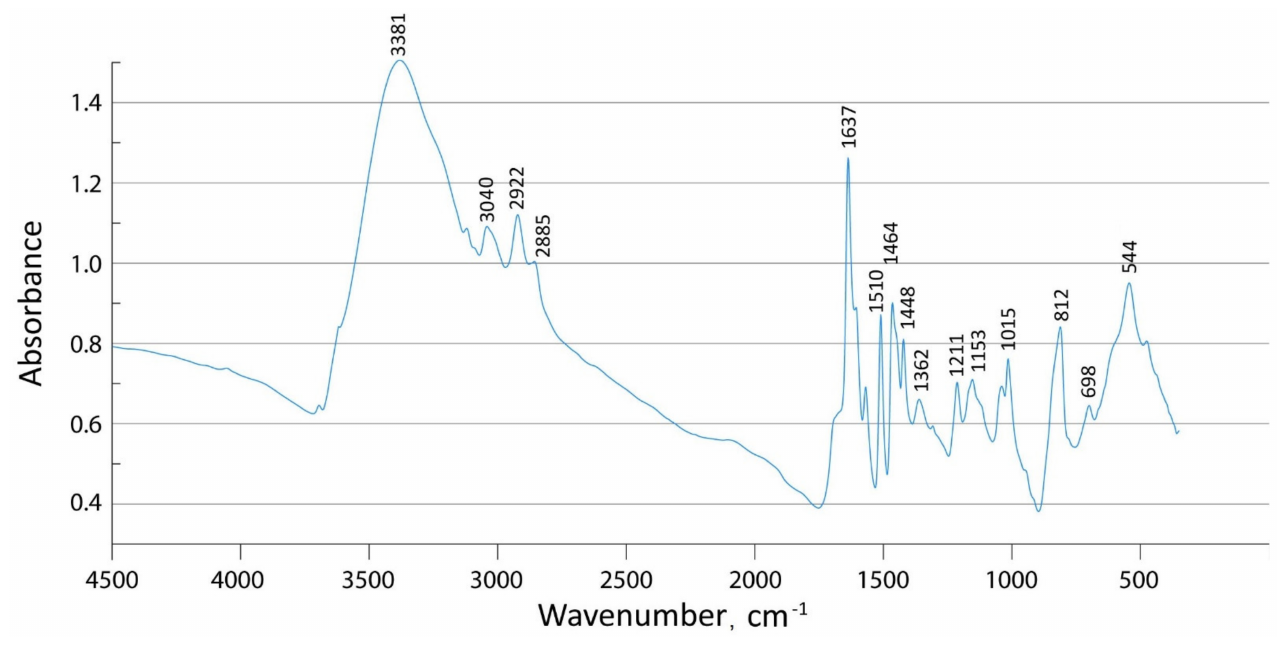
Figure 2. FTIR spectrum of